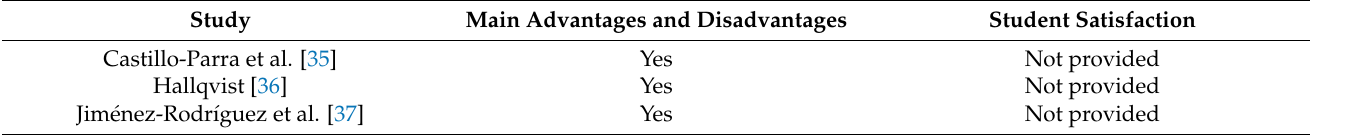
Table 4. Secondary outcomes ( n =